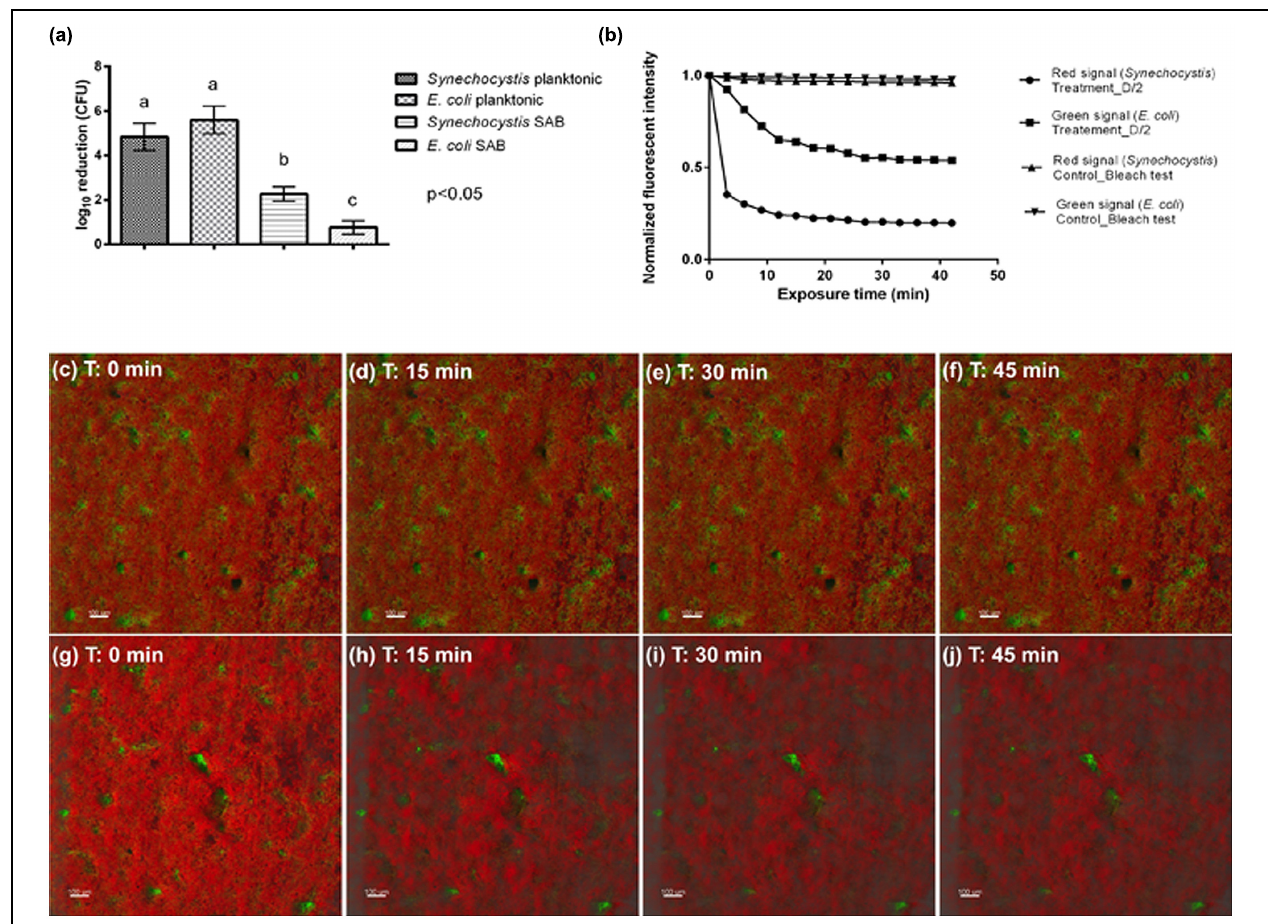
FIGURE 5 | Antimicrobial effectiveness of D/2 solution. (a) Susceptibility of Synechocystis and E. coli in planktonic cultures and SABs observed as log 10 reduction in the number of CFU after exposure to the antimicrobial agent. Data represent the mean ± standard deviation of three independent measurements. The letters above the histogram represent the results of Tukey’s post hoc comparisons of group means. According to post hoc analysis ( p < 0.05), means sharing the same letter are not significantly different from each other. (b) Quantification of biofilm fluorescence intensity lost during exposure to the biocide. (c–f) Real-time loss in cell viability over time in absence of a biocide treatment (control sample). (g–j) Real-time loss in cell viability over time in presence of the biocide treatment (treated sample). Color key: E. coli cells, green; Synechocystis cells,